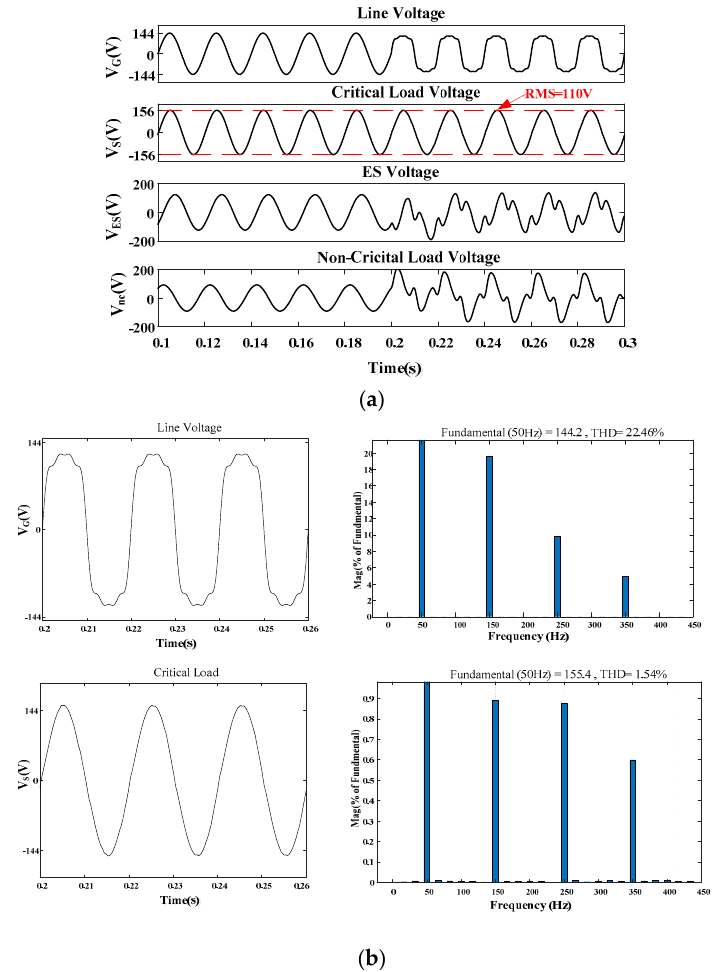
Figure 7. The simulation waveforms based on the dead-beat with observer and δ control under the pure reactive power compensation mode. ( a ) Comparison between ideal grid condition and distorted condition; ( b ) FFT analysis of line voltage and critical load voltage under distorted grid